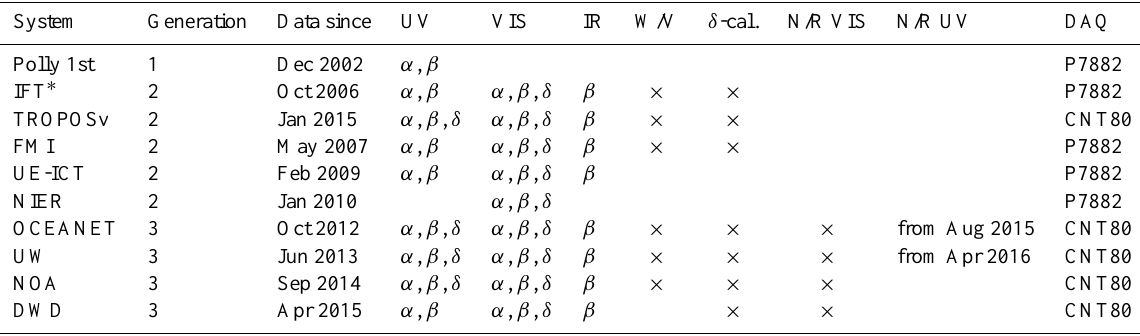
Table 1. Measurement capabilities of the different Polly systems at UV (355nm), VIS (532nm), and IR (1064nm) wavelengths. Water-vapor (W/V) channels and absolute calibration of the depolarization channels ( δ -cal.) have been installed in most of the systems. The four most recent systems include a near-range (N/R) telescope in addition at 532 and 607nm wavelengths. A new setup with additional N/R channels at 355 and 387nm wavelengths has been recently developed. Three different data acquisition (DAQ) systems have been in use so far (see Sect.